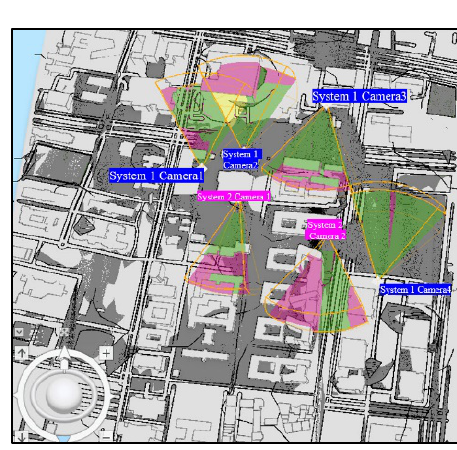
Figure 5. Single System of CCTV’s coverage